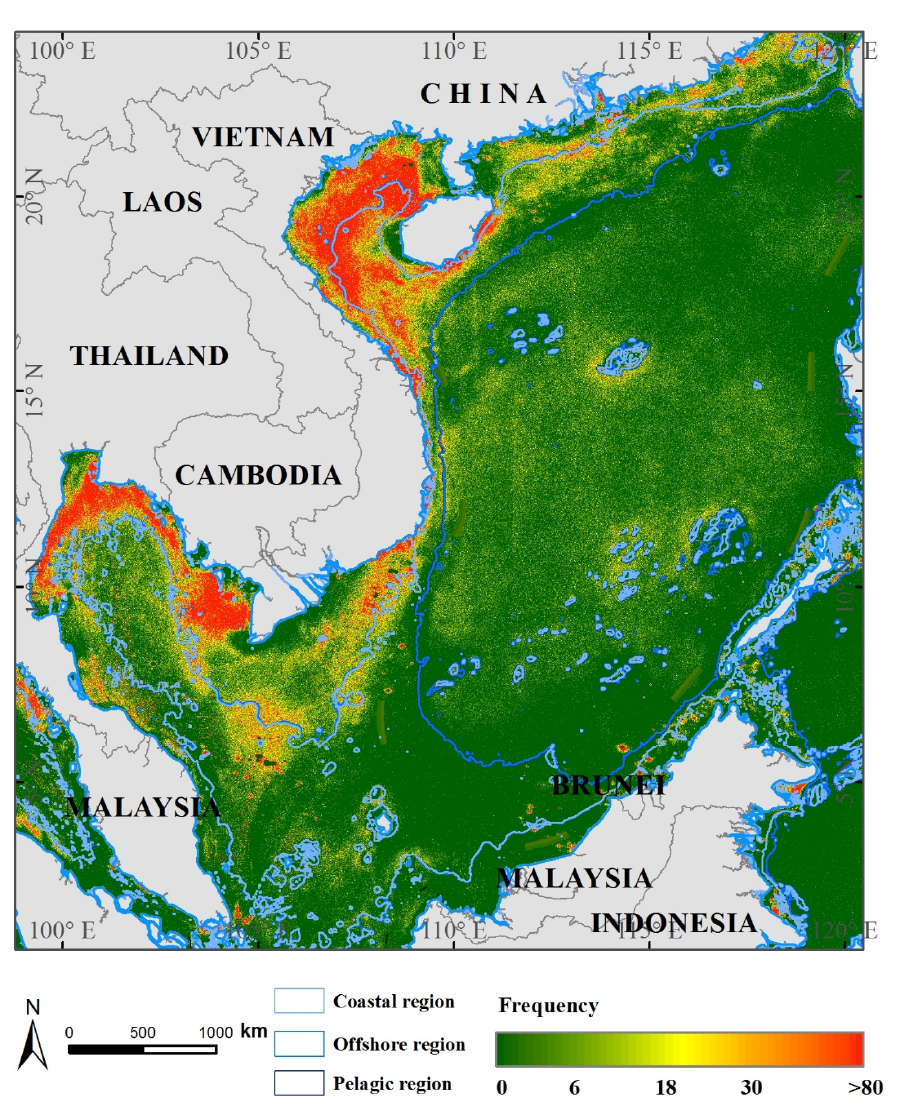
Figure 6. Occurrence frequency of nighttime fishing activity in the SCS during 2012–2019.